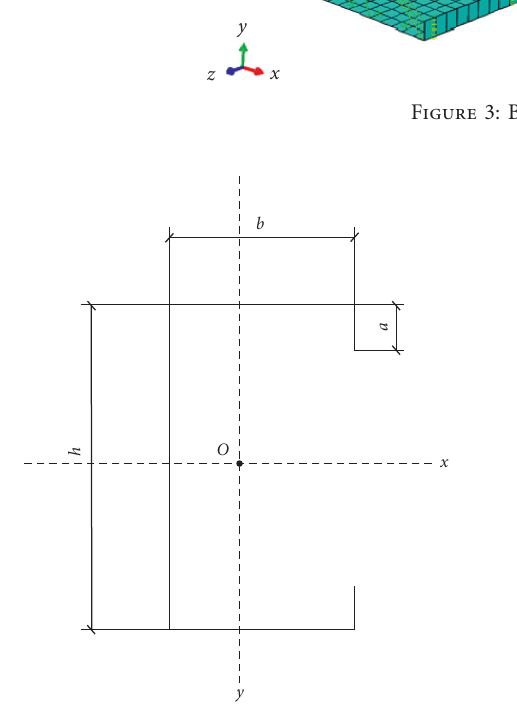
Figure 4: Section diagram. Table 3: Dimensions and properties [19].